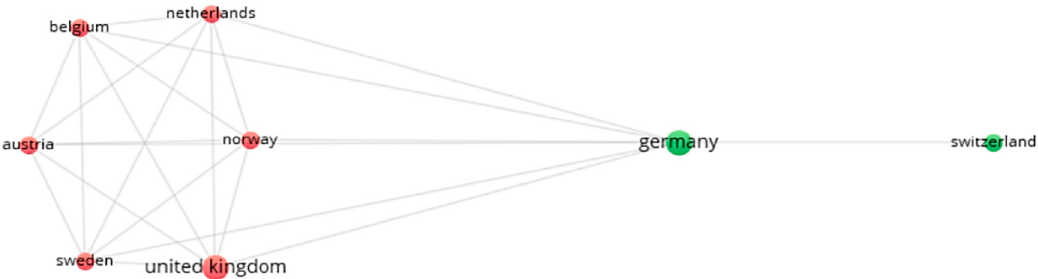
Figure 4. Network map for spatial measurement of research top 10 publications within